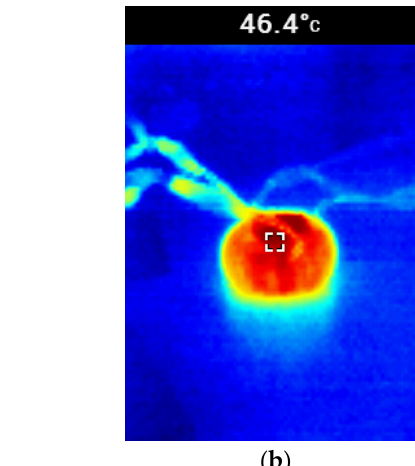
Figure 15. MFT input and output voltages and currents at full load: ( a ) Nanocrystalline, ( b ) Ferrite.